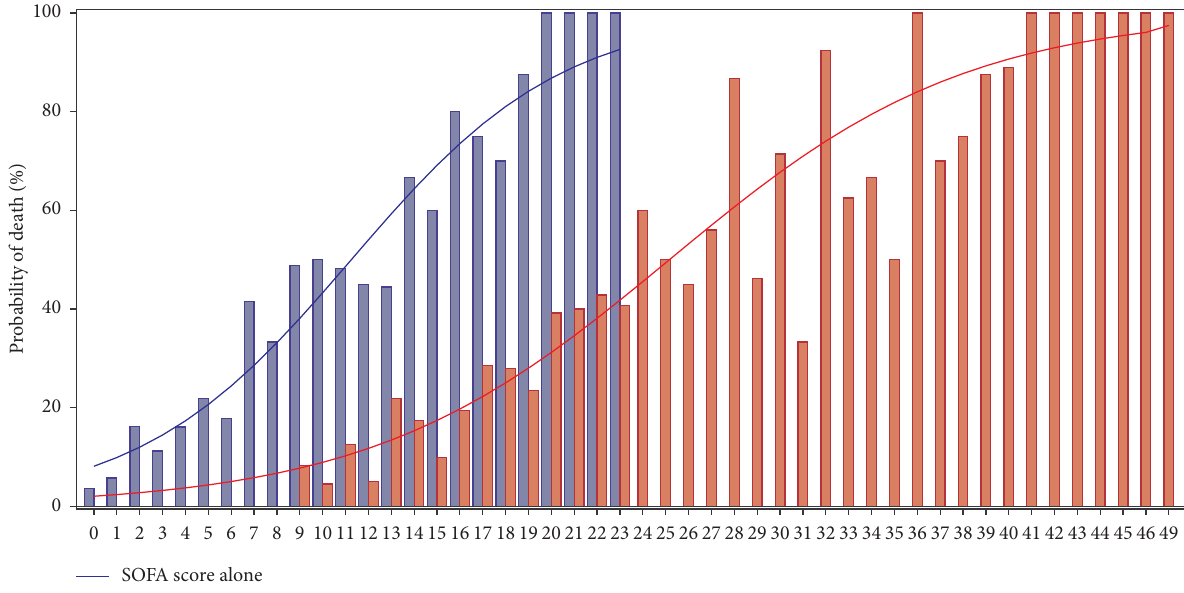
Figure 2: Predicted probability of in-hospital mortality within 90-days of intensive care admission for severity scores. Histograms represents observed probability of death and lines represents predicted probability of death. SOFA, Sequential Organ Failure Assessment; MACA, metabolic failure, age, and comorbidity assessment. No patient had a total SOFA score of 24 points in our study. No patient had a total combined “SOFA+MACA” model score of 50 points or